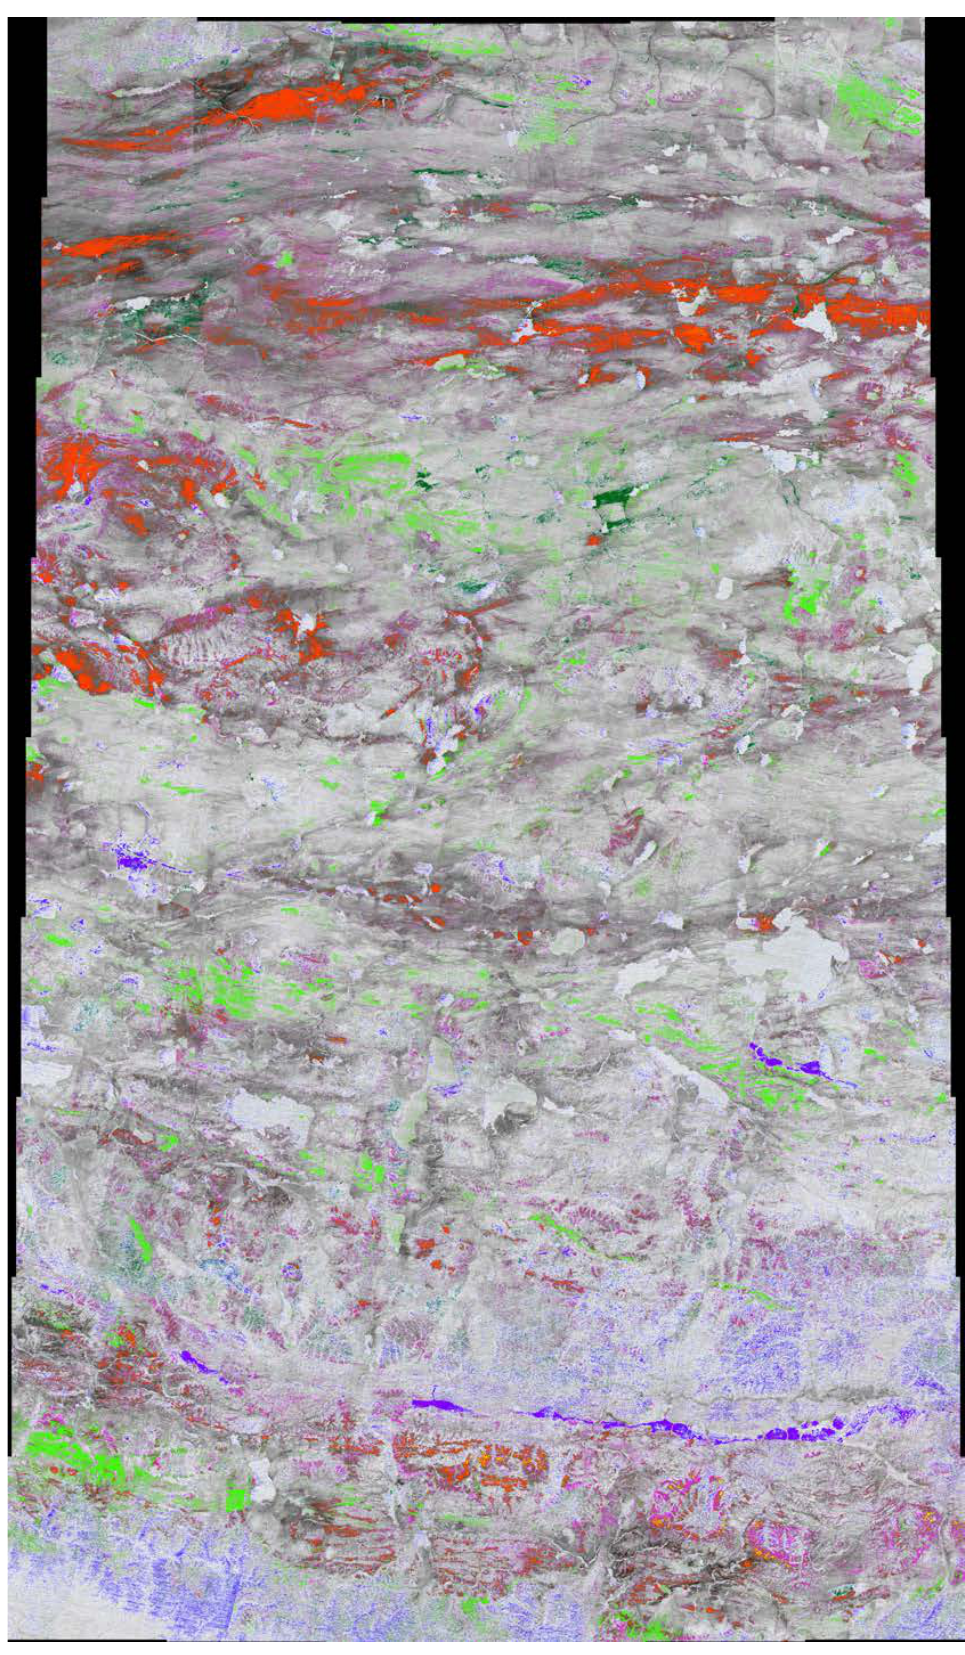
Figure A6. High resolution version of Figure 6 without annotated information.